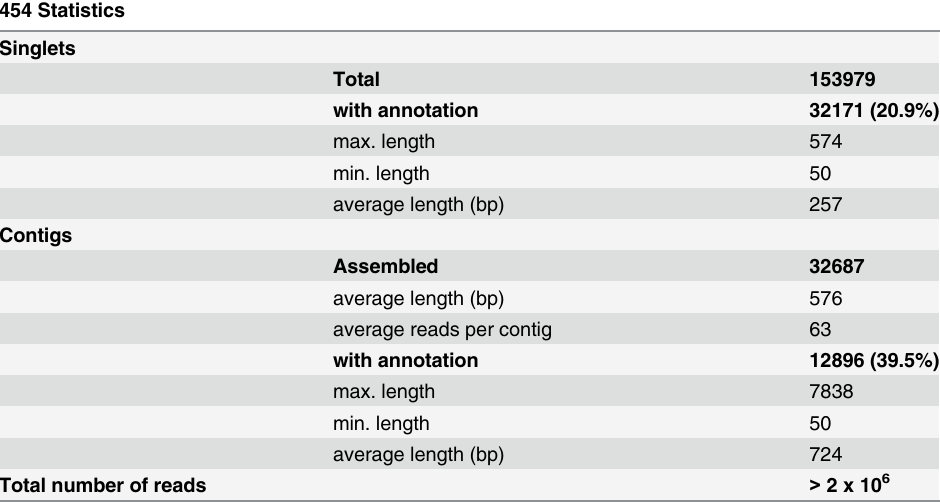
Table 1. 454 reads statistics. Description of different properties of sequenced transcripts, assembly and